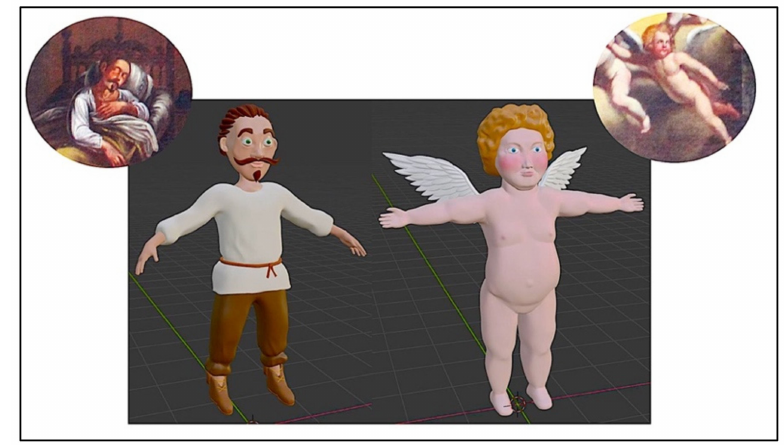
Figure 3. 3D character modelling.